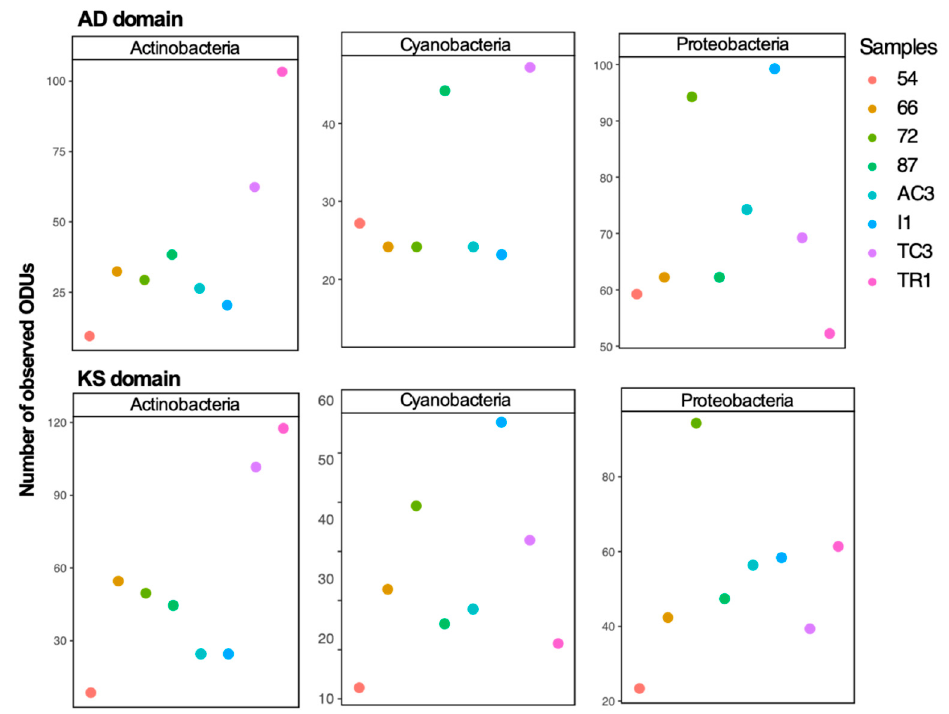
Figure 3. Alpha-diversity (number of OTUs grouped at 97% and in a second round at 95%) of KS and AD domains of Actinobacteria, Cyanobacteria, and Proteobacteria phyla.